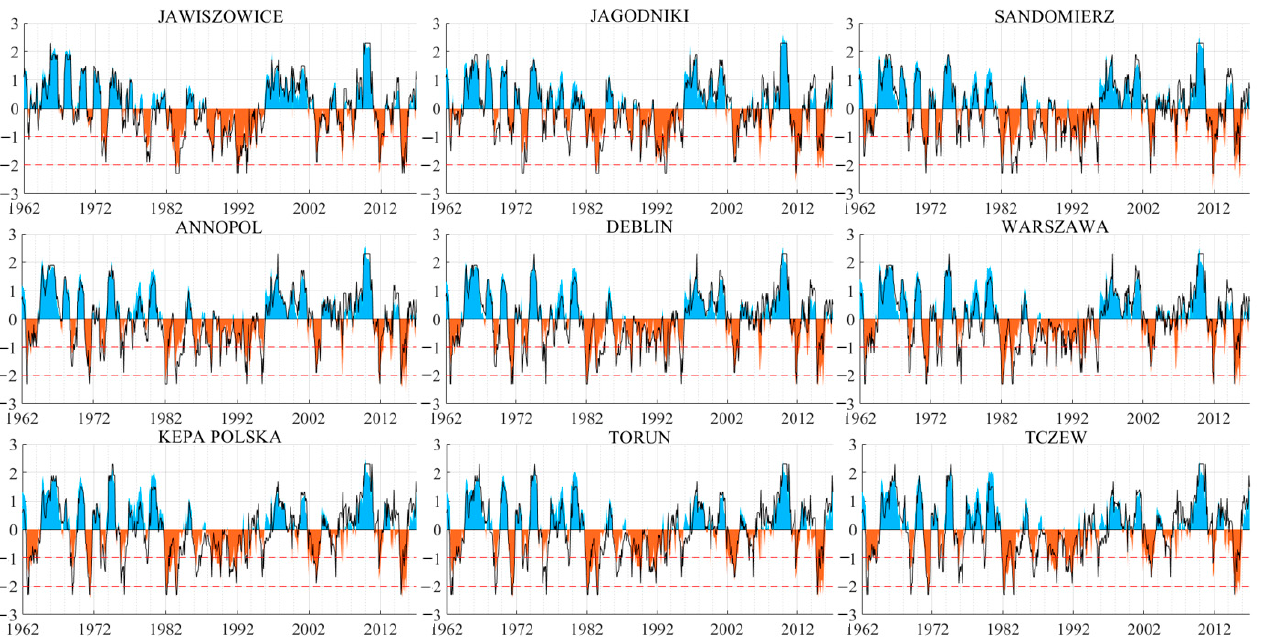
Figure 9. The SPEI12 (stacked blue/orange area) and SPI12 (scatter with straight lines) on a 12-month timescales at nine sub-basins along the main channel of the Vistula River.